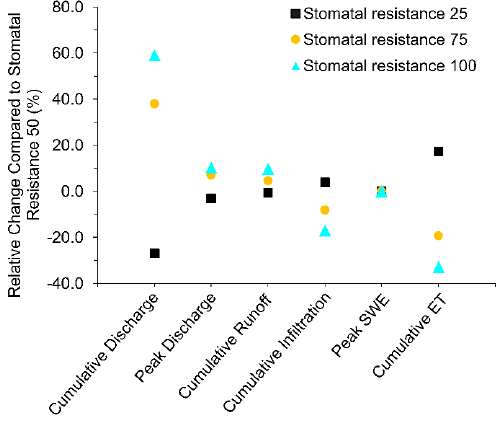
Figure 10. Sensitivity of major hydrological processes to changes in stomatal resistance (sm − 1